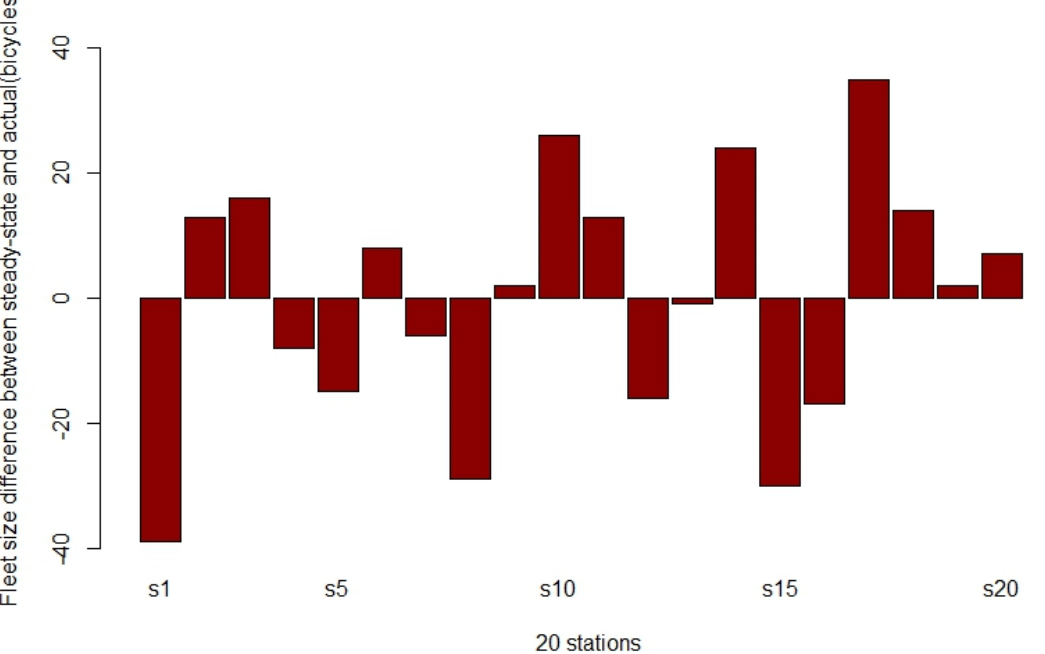
Figure 6. Statistical diagram of actual fleet size vector for dockless bike-sharing stations. In Figure 6, the horizontal axis represents the stations and the vertical axis represents the actual fleet size of stations.